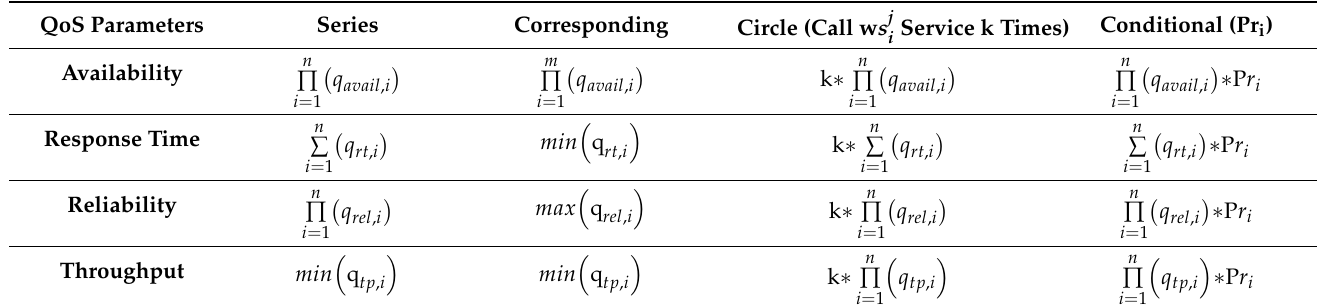
Table 1. QoS accumulation tasks with different